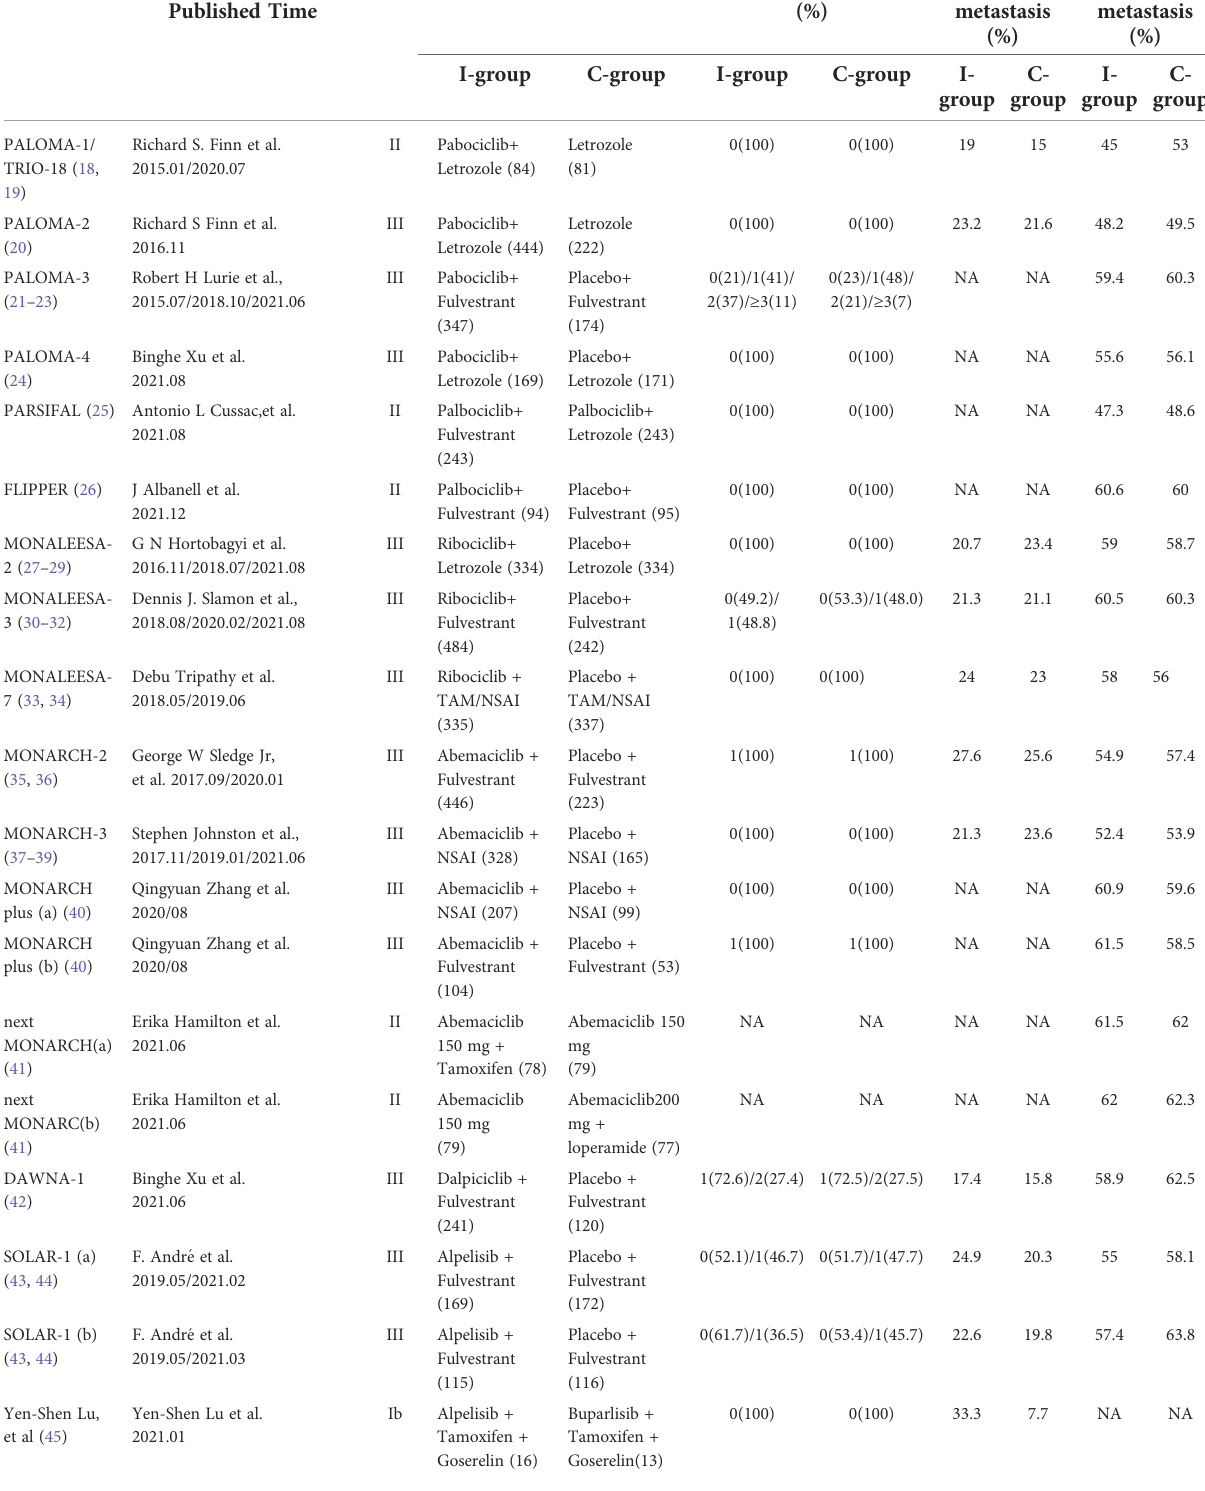
TABLE 1 Baseline characteristics of 28